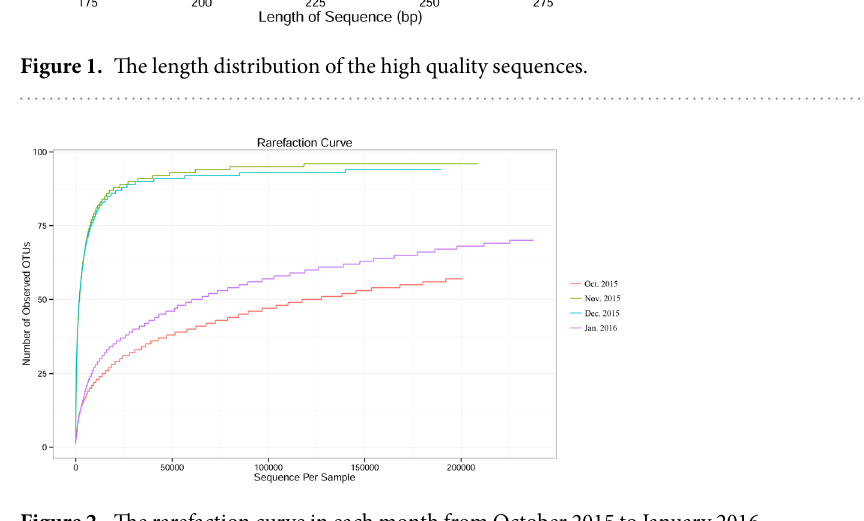
Figure 2. The rarefaction curve in each month from October 2015 to January